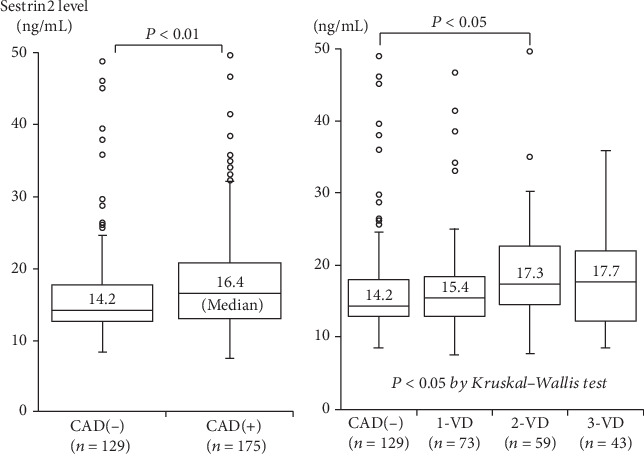
Plasma sestrin2 levels and the presence of CAD or the number of stenotic coronary vessels. Plasma sestrin2 levels were significantly higher in CAD than in CAD(-) (a). Moreover, sestrin2 levels in 4 groups of CAD(-), 1-VD, 2-VD, and 3-VD were 14.2, 15.4, 17.3, and 17.7 ng/mL, respectively, and were the highest in 3-VD (P < 0.05 by Kruskal-Wallis test) (b). The central line represents the median, and the box represents the 25th to 75th percentiles. The whiskers represent the lowest and highest values in the 25th percentile minus 1.5 IQR and 75th percentile plus 1.5 IQR, respectively.